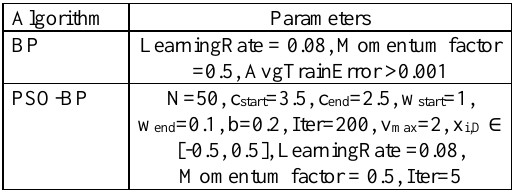
Table 2 . Algorithm parameters setting